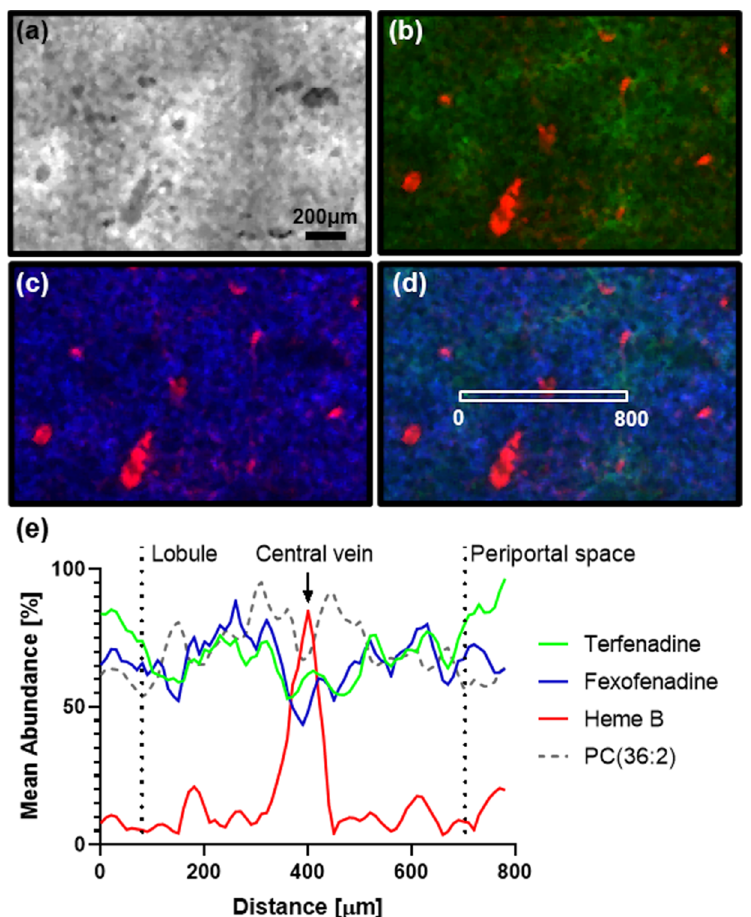
Figure 5. ( a ) Hepatic lobule of a fresh frozen liver section outlined by PC(36:2) ( b ) Terfenadine (green) in relative distribution to Heme B as determined by high resolution MALDI-MSI. ( c ) Distribution of Fexofenadine (active metabolite) compared to Heme B ( d ) RGB overlay of Terfenadine, Fexofenadine and Heme B. The box highlights the pixel used for the profile plot. ( e ) Profile plot of the normalized mean abundances of terfenadine, fexofenadine compared to PC(36:2) outlining the hepatic lobule and Heme B marking the central vein. Data is represented as mean of 3 separate lines, normalized to the highest pixel and cubically smoothed over 3 neighboring pixels to compensate for pixel-to-pixel variability.